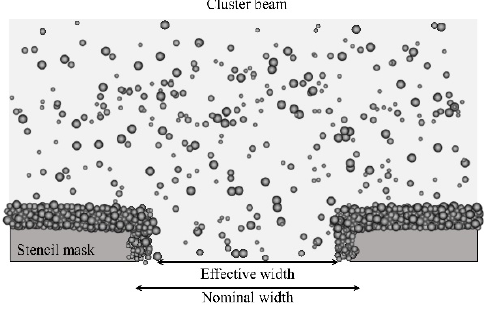
Figure 7. Schematic representation of the clogging effect due to accumulation of zirconia clusters inside the stencil mask’s opening: the nominal width of the stencil mask opening is progressively reduced to a smaller effective width as the deposition is carried out.